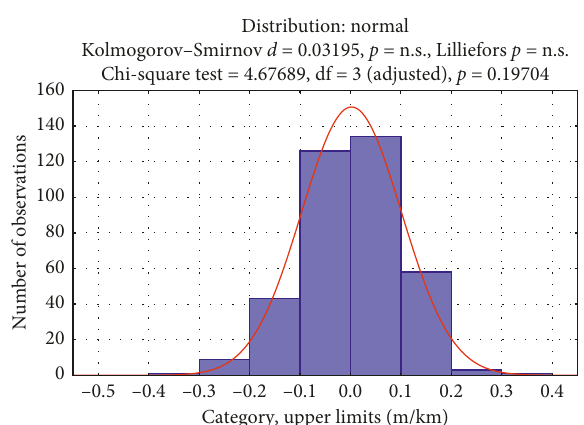
Figure 6: Measured versus predicted IRI training and test data.